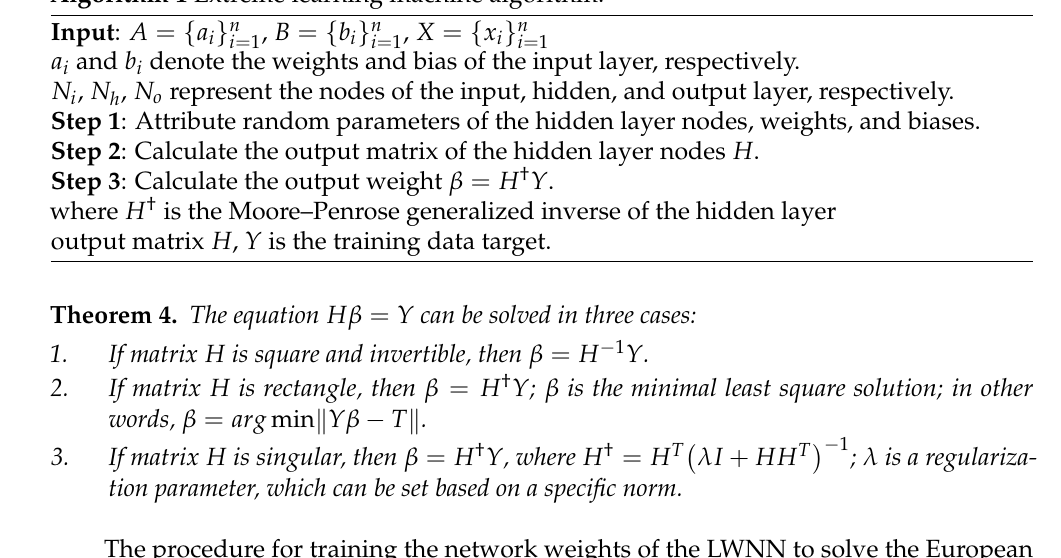
Algorithm 1 Extreme learning machine